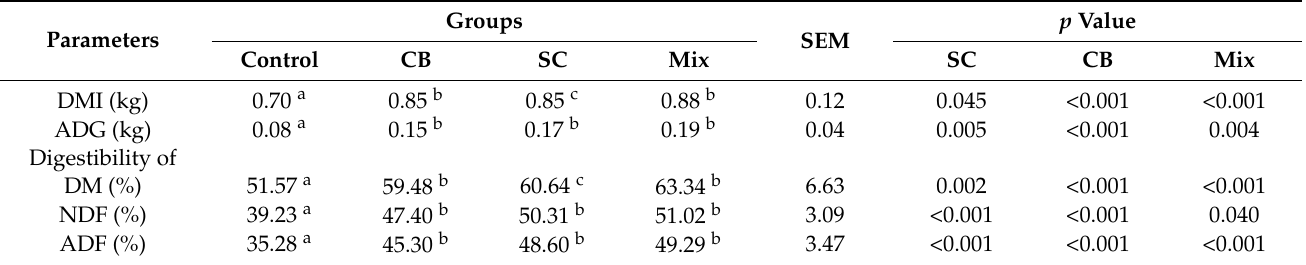
Table 5. The parameters of growth performance in heat-stressed goats with probiotic